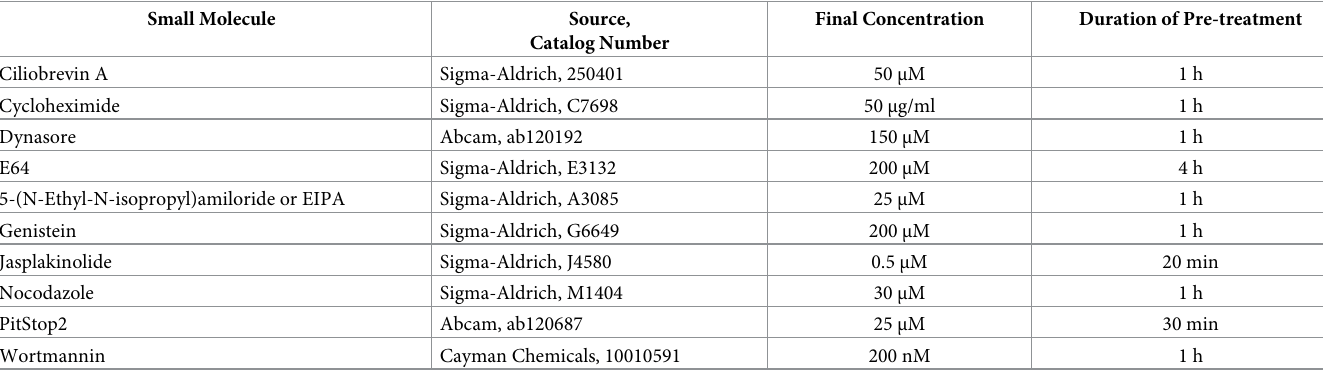
Table 1. Treatment of neurons with small molecule inhibitors. Small